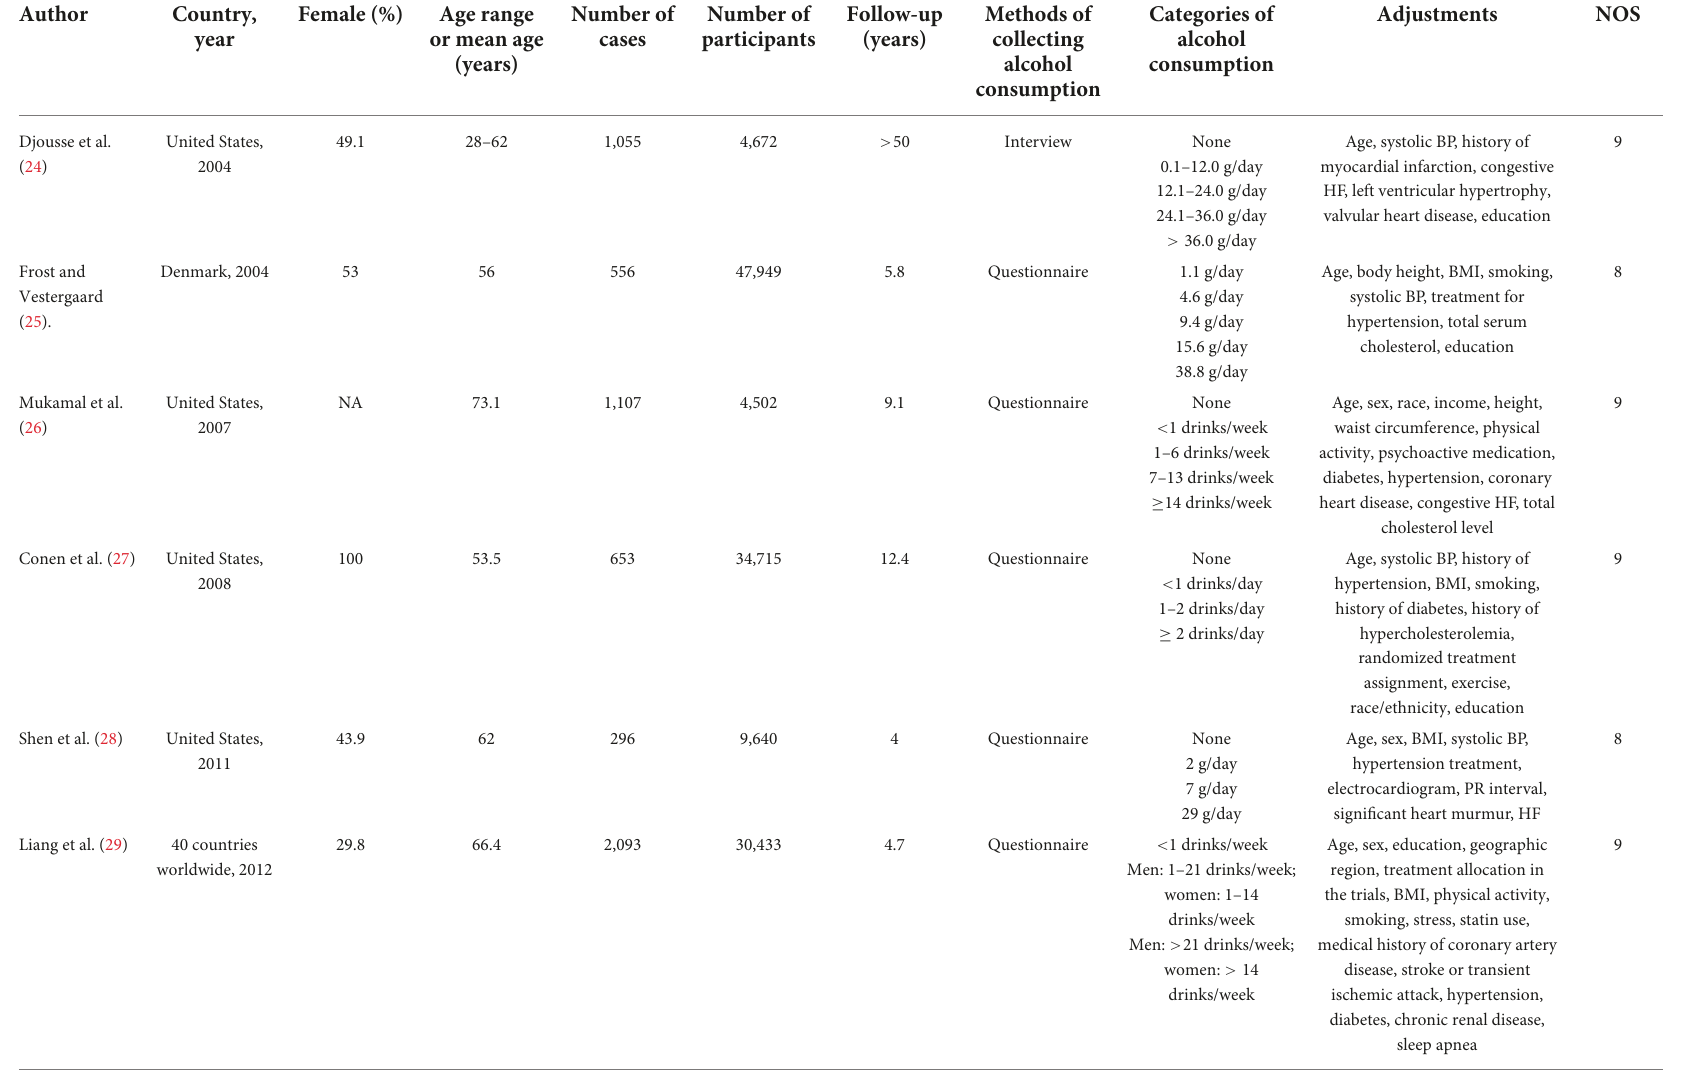
TABLE 1 Characteristics and data of included